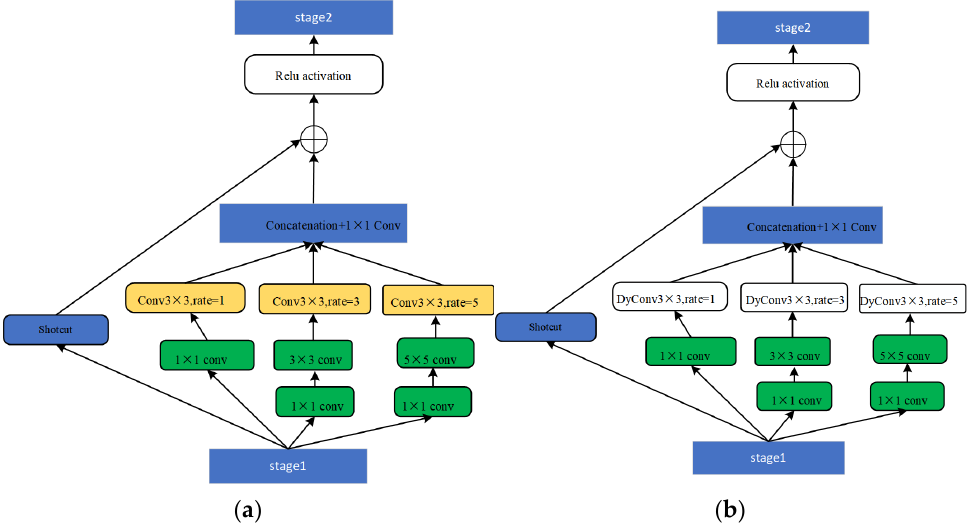
Figure 3. ( a ) RFB module; ( b ) DyC-RFB module.